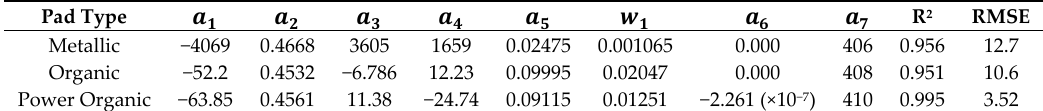
Figure 2. ( a ) Example dynamometer transient experimental data for power organic pad friction test. Power is calculated, and all other parameters are measured; ( b ) Example experimental data points (colored by temperature) and curve fitted friction response surface (gray) for the power organic pad from room temperature to approximately 560 K; ( c ) Scatter plot of the metallic, organic, and power organic pad experimental friction forces, colored by temperature, with curve fits superimposed at 408 K; ( d ) Friction coefficients vs. temperature as extracted from the curve fitted response surface for each pad (for 450 N normal force on a total pad area of 815 mm 2 , or 552.1 kPa equivalent pad normal pressure), with error limits shown as dashed lines based on the curve fit RMSE values. Table 1. Curve fitting coefficients for Equation (3) for the three types of brake pads that were tested. The quality of fit for the upper equation [A], which accounts for most of the data, is shown via R 2 (i.e., R-Square; coefficient of determination) and RMSE (Root mean squared error or also known as fit standard